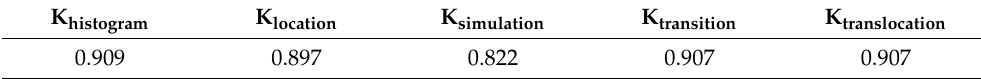
Figure 2. Comparison of stimulated and observed land use in Xi’an 2015, ( A ) Simulated land use; ( B ) Observed land use. Table 2. Ksimulation coefficients from comparing observed and simulated